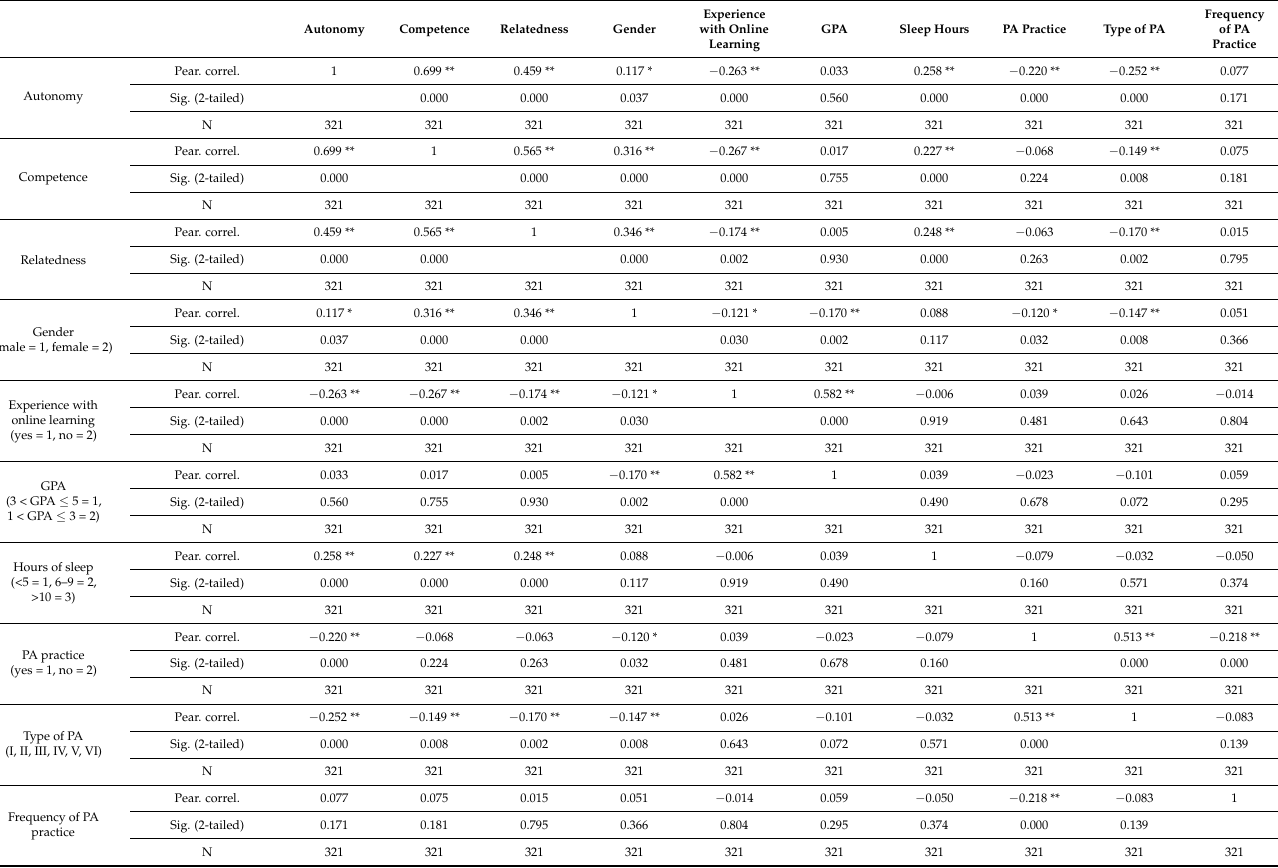
Table 5. Relationship between autonomy, competence, relatedness, and all the independent